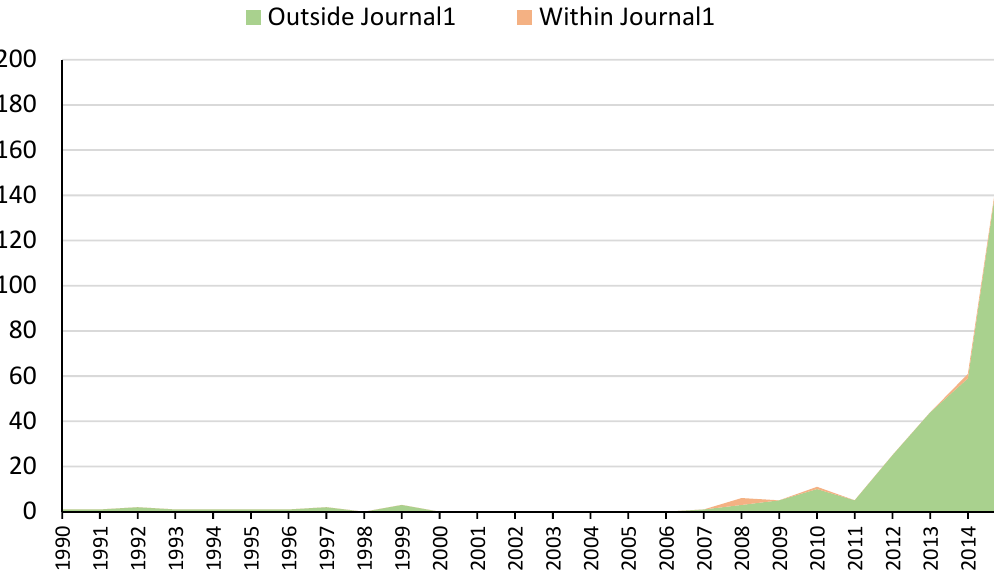
Figure 6. Citations of Author5’s papers in WoS distinguishing between citations of Author5’s papers, wherever published, whether cited or not in Journal1.